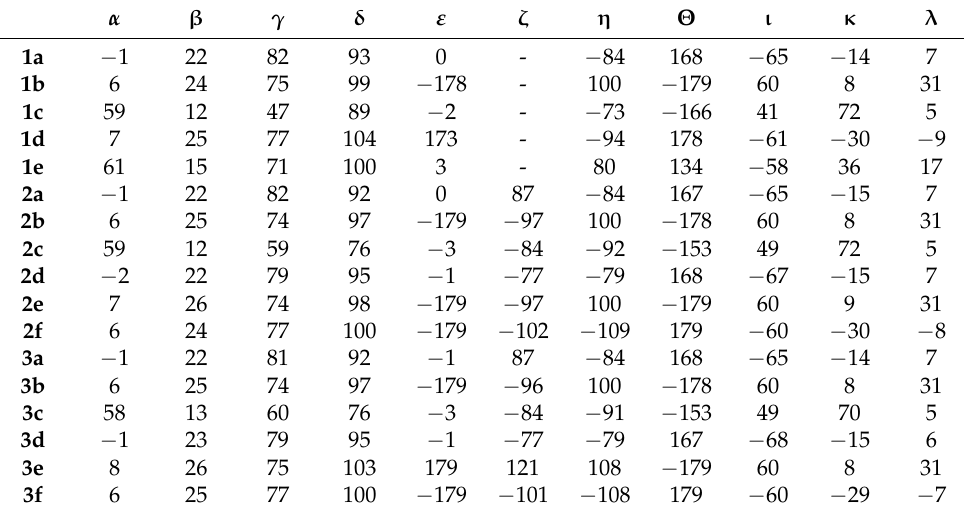
Table 3. Selected dihedral angles (degree) for the preferred conformers of 1–3 according to